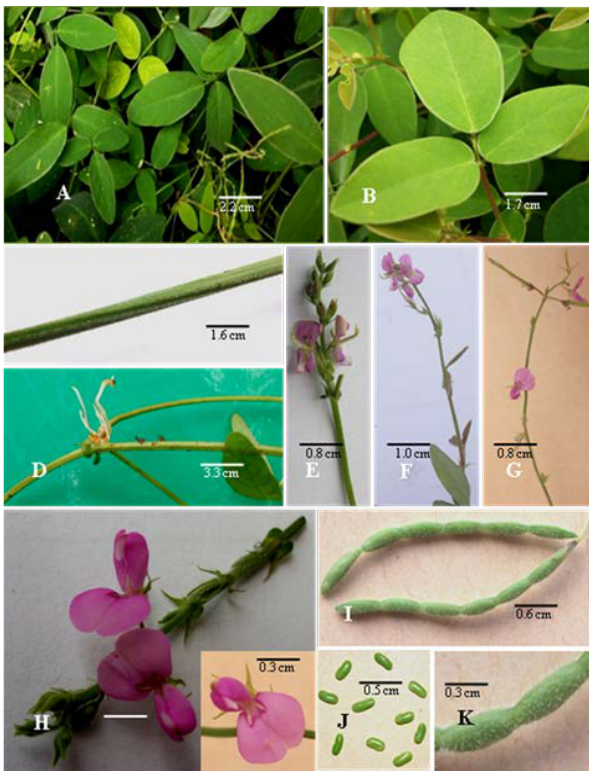
Fig. 1. Morphology of Desmodium tortuosum (Sw.) DC A. Habit (herb/under shrub), B. Leaf, C. Stem, D. Inflorescence, E. Flower, F. Seeds (arrow points at depression), G. Fruit (fresh), H. Fruit (dry and twisted), I. Fruit (showing reddish brown pattern and hairs on fruits